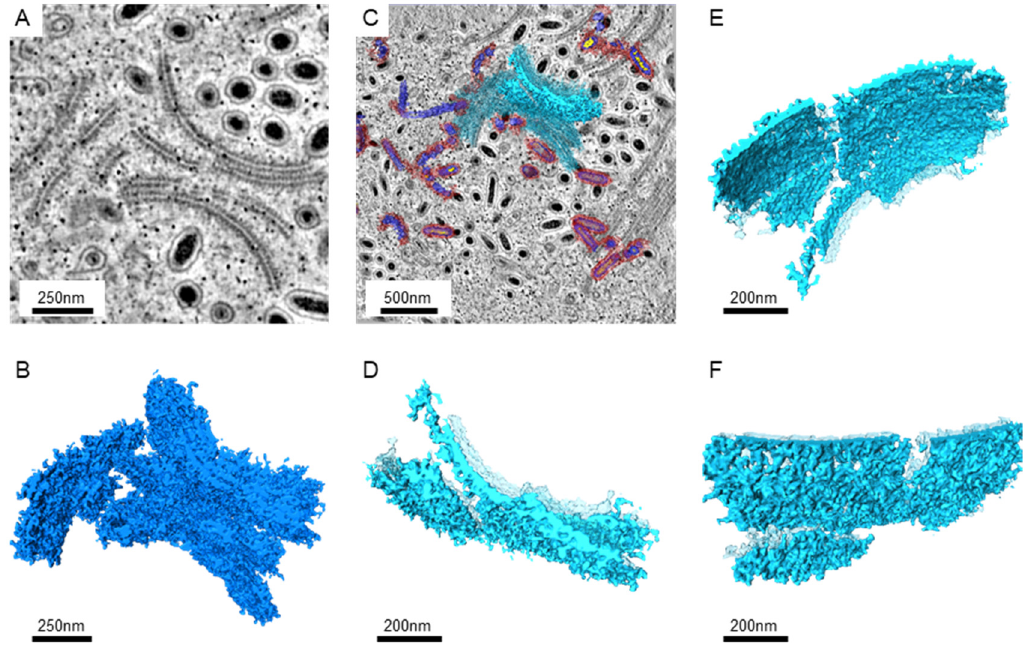
Figure 2. The images of the paired sheet-like structures in the WSSV-infected nucleus. ( A ): The representative image from the tomograms shows sheet pairs. The Gaussian filter was applied to reduce the noise. ( B ): The 3D structures of the sheet pairs were obtained from the serial sections near the area shown in A. The segmentation of the tomograms was performed manually with the threshold filter. ( C ): The image shows the position of the selected sheet structures near the area shown in A. The background image shows the cross-section at another z-axis level. The selected sheet is shown in solid azure color, while other sheets and segmented particles were shown in transparent colors. ( D ): The top view of the selected sheet is shown in high magnifications. The sheets without selection are shown in transparent azure color. ( E ): The side-view of the selected sheet shows the inner surface between the sheet pairs. ( F ): The side-view shows the outer surface of the selected sheet pair.